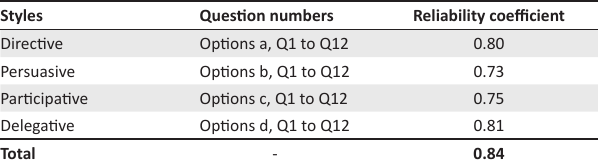
Findings The first hypothesis: